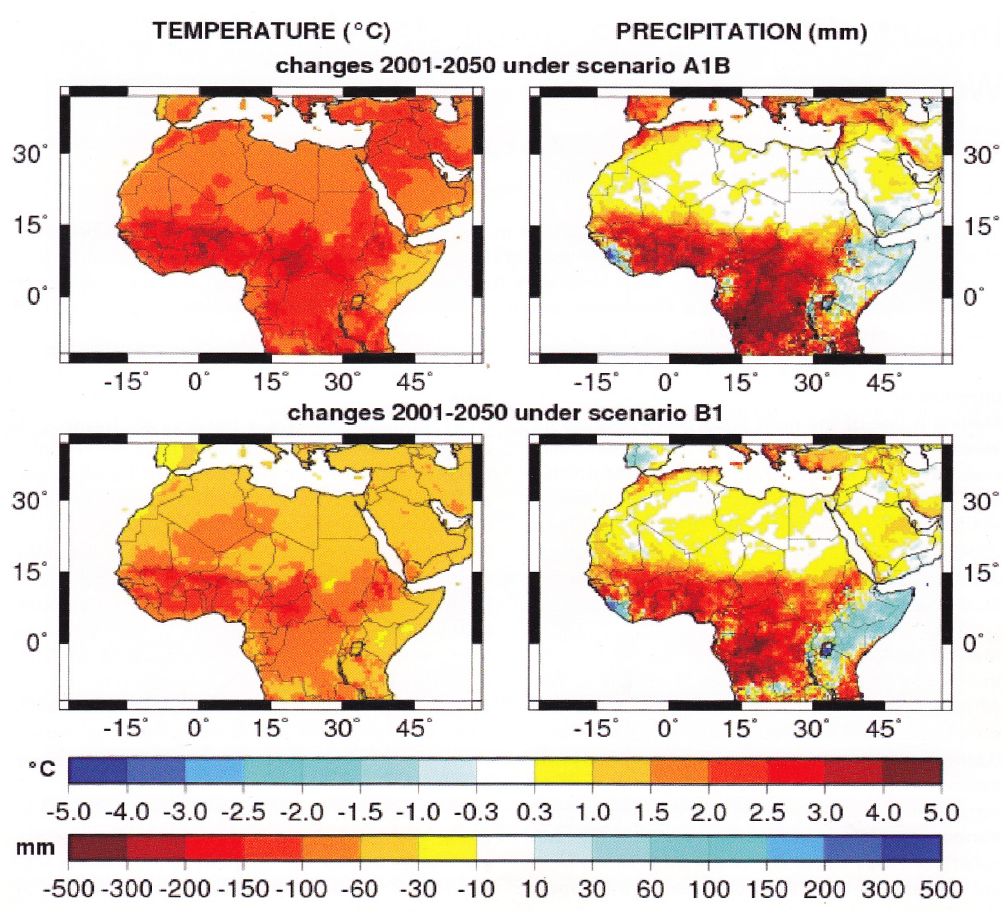
Figure 9. Projected changes in annual precipitation and near-surface temperatures until 2050 over tropical and northern Africa due to increasing greenhouse gas concentrations and man-made land cover changes [55]. The scenario A1B describes a globalized world of rapid economic growth and comparatively low population growth. The scenario B1 also characterizes a future globalized world with a low population